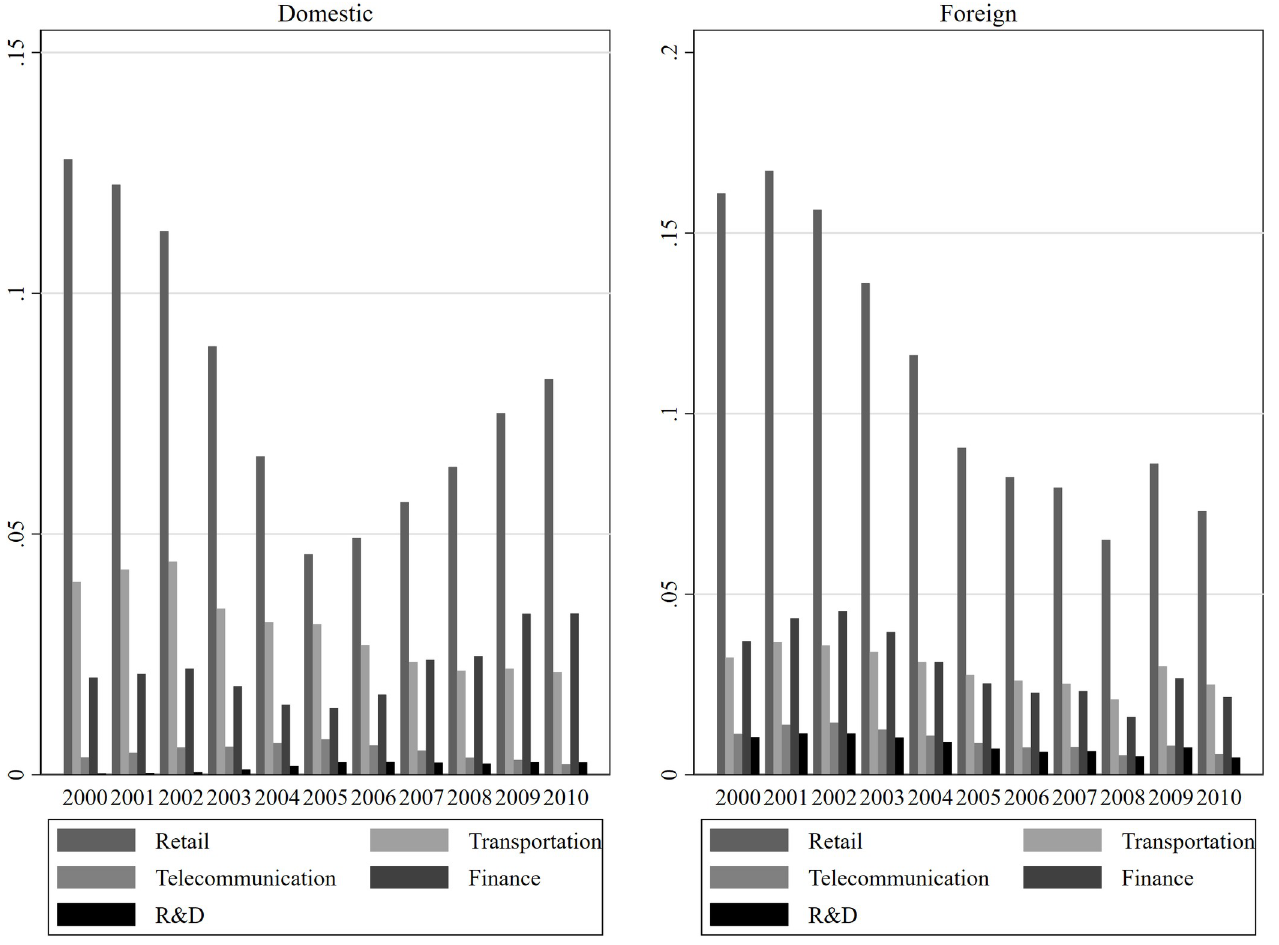
Fig 5. The changing characteristics of manufacturing servitization in